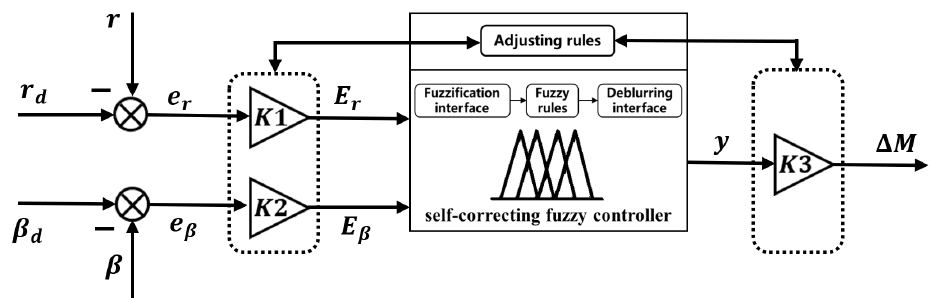
Figure 5. Additional yaw-moment calculation based on the self-correcting fuzzy controller.